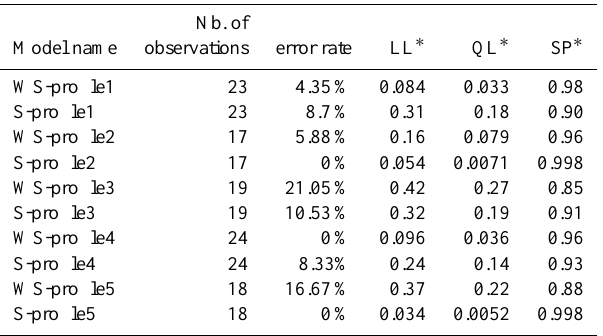
Table 7. Statistical performance of country profile models for WS and S. Nb. of